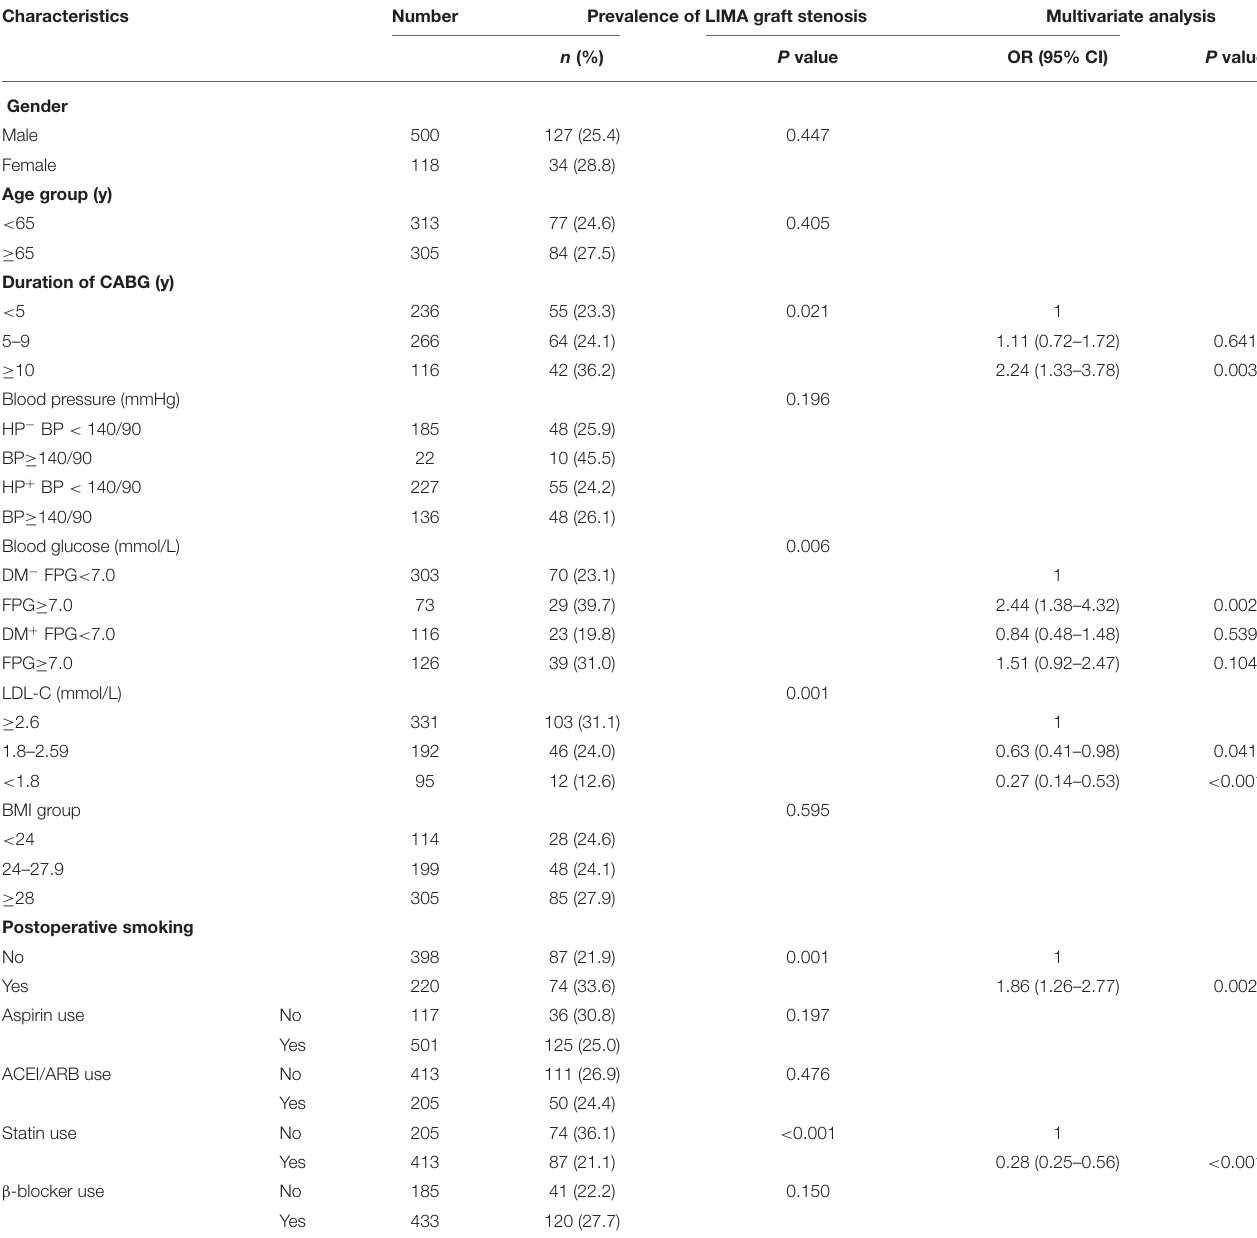
TABLE 3 | Prevalence of LIMA graft stenosis and the relationship between LIMA graft stenosis and conventional RFs. Characteristics Number Prevalence of LIMA graft stenosis Multivariate